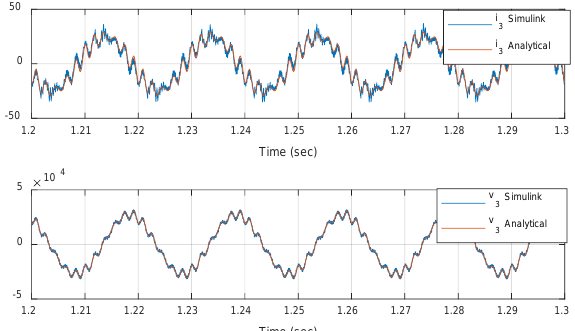
Figure 22. The ACISEF operating as an active pure resistance of 10 Ω (at the low voltage side) to 550 Hz and 7 Ω (at the low voltage side) to 650 Hz. Comparison of i 3 α and v 3 α variables of the system, for the analytical model and the Simulink detailed model (including discrete control loops, modulation, delays, and compensations).